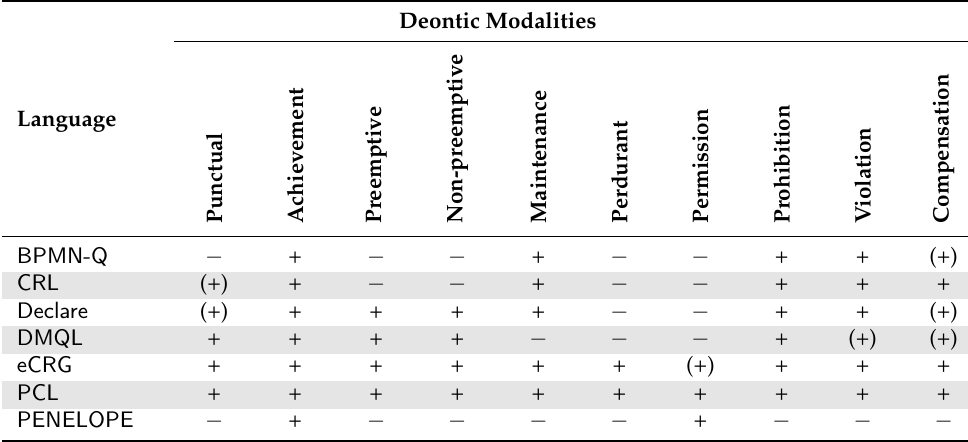
Table 16. Expressiveness from a legal-reasoning